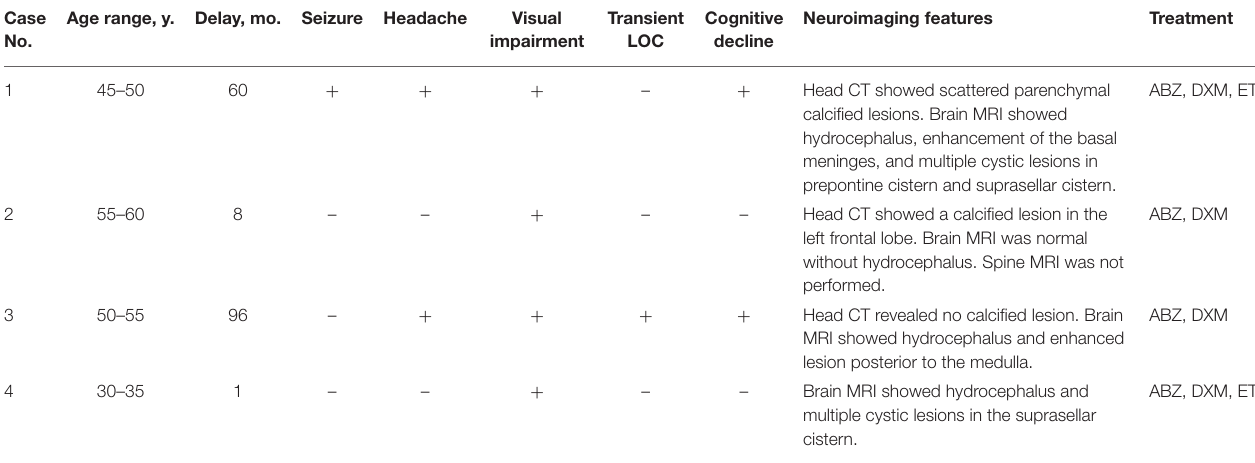
ABZ, DXM ABZ, DXM, ETV